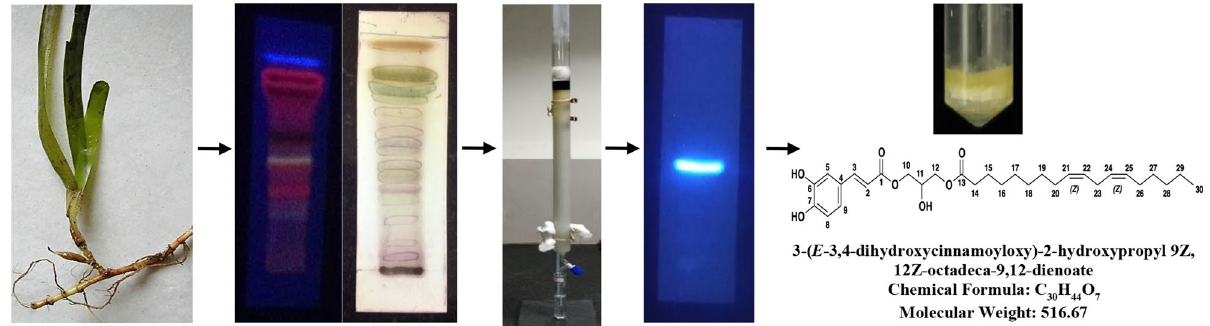
Figure 1. Cymodocea serrulata ; Thin Layer Chromatograms of the active chloroform extract (hexane: ethyl acetate; 6:4) viewed at 356 nm and white light (derivatizing agent—methanol: sulphuric acid, 9:1); The